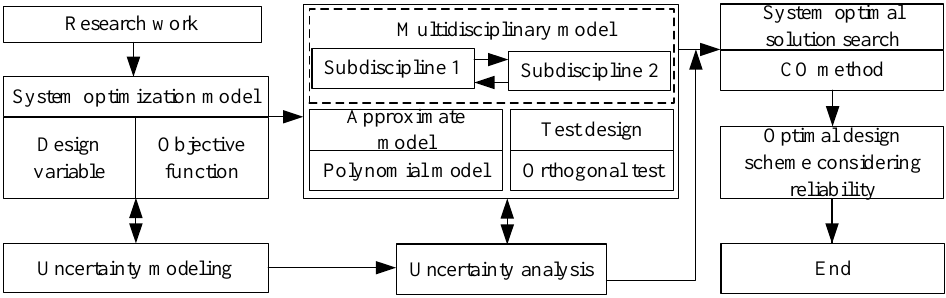
15 of 23 Table 3. Uncertainty description of each interval variable in the rotor mechanism design optimiza- tion problem. Interval Variable Upper Bound of the Interval Lower Bound of Interval β 0 0.96 The reliability design optimization model of the rotor mechanism considering the uncertainty information of each random and interval variable is: (